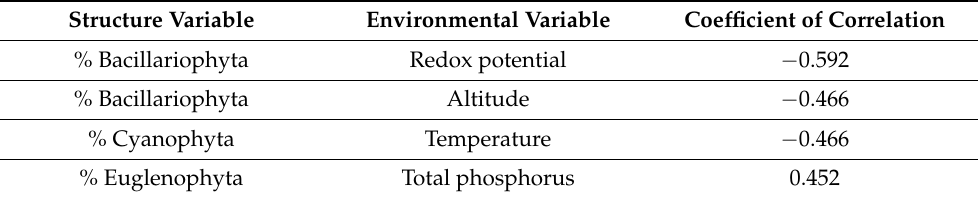
Figure 2. Principal component analysis (PCA) including seventeen variables in total: two geographic (altitude and surface), seven physical and chemical (conductivity, nitrates/nitrites, oxygen concentration, pH, redox potential, water temperature, and total phosphorus), and eight biological variables related to phytoplankton (Chlorophyll-a, total biovolume, %Chlorophyta, %Bacillariophyta, %Cyanophyta, %Chrysophyta, %Euglenophyta, and %Pyrrophyta). Dots represent lakes. Table 2. Coefficients of correlations amongst composition variables (contribution of each phyla to total biovolume) and environmental variables. Only correlation coefficients over 0.45 and with p < 0.05 are shown.